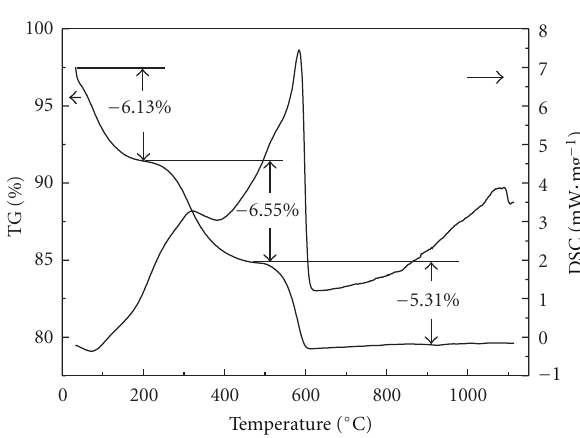
Figure 8: TG-DSC curves of TiO 2 /MCM-41 sample.